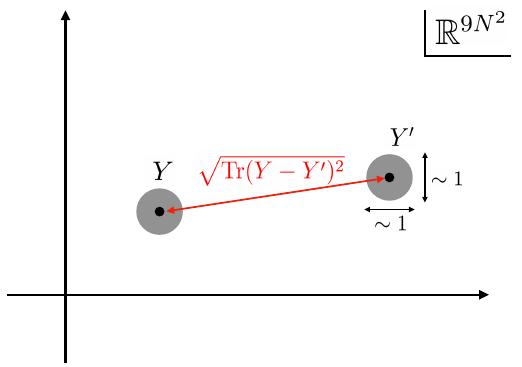
Figure 2 . Each wave packet smoothly spreads in R 9 N 2 . Along each of 9 N 2 dimensions, the size of the wave packet is at most of order N 0 . Two wave packets centered around Y and Y 0 in R 9 N 2 have vanishingly small overlap if the centers of wave packets are well separated, i.e., p Tr( Y − Y 0 ) 2 (cid:29) 1